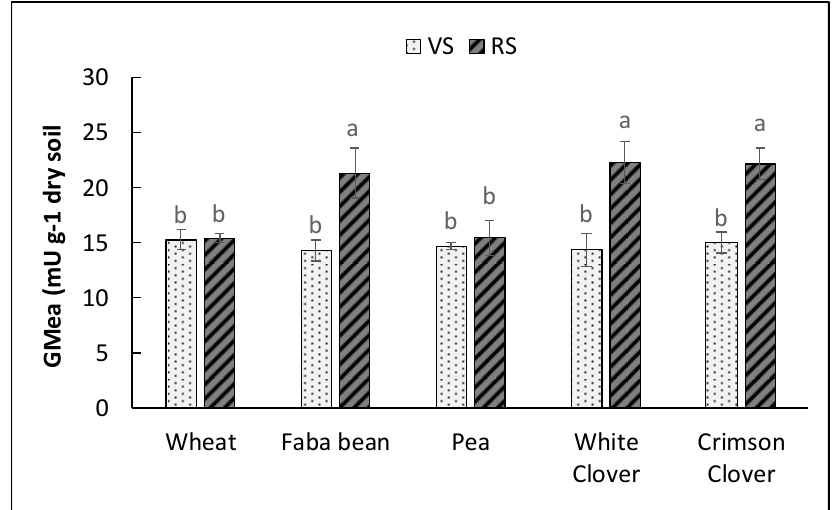
Figure 3. Patterns of the geometric means (GMea) of BG, NAG and ACP activities at the two development stages. BG: β -glucosidase; NAG: N-acetyl-glucosaminidase; ACP: acid phosphatase; VS: vegetative stage; RS: reproductive stage. GMea was calculated by using only the three enzyme activities that varied according to the plant’s species. GMea = ∛ (BG × NAG × ACP). Data are mean ± SD (n = 5). Letters indicate statistically significant difference between plants species and development stages at p < 0.05 according to Tukey’s test.